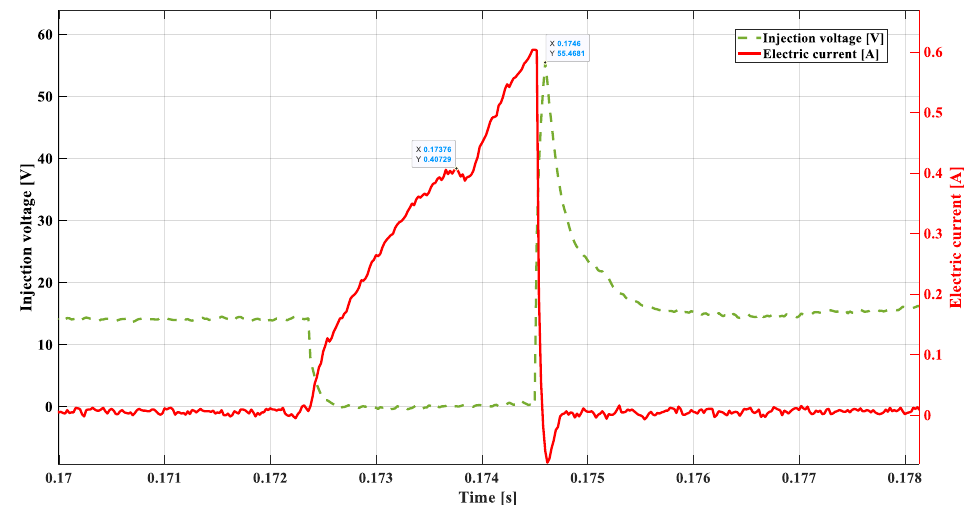
Figure 11. Real waveform of electric voltage and current at 800 rpm.